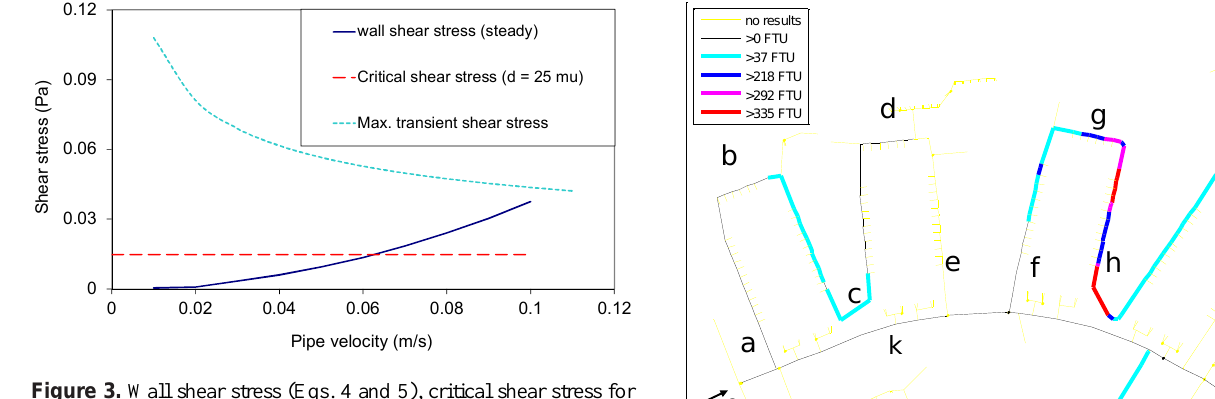
unsteady shear stress (eq. (6)) 3